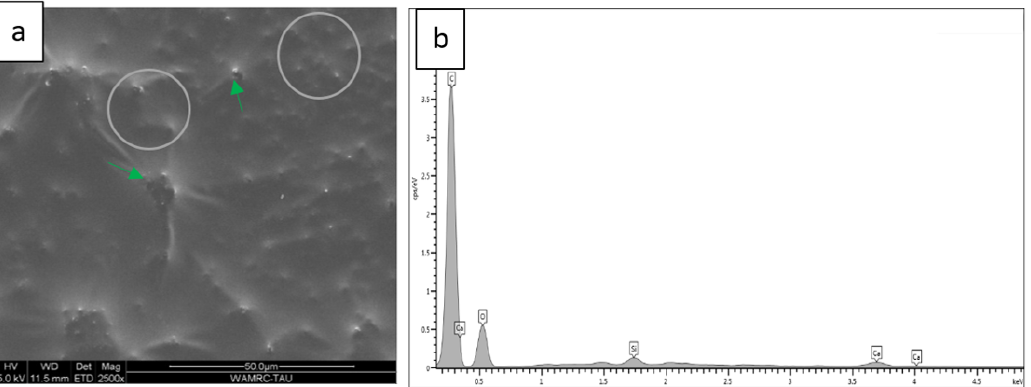
Figure 10. Microscopic images of air-abraded, acid-etched, and SCMP-treated dentin. The adhesive covers the surface and occludes most of the tubules ( a ). Several partly open tubules can be discerned (green arrows). White circles denoted the area of the EDS analysis, which revealed the following elements (wt %): C 63.13%, O 30.72%, Ca 2.2%, P 0.48%, Si 2.05%, Al 0.88% ( b ).